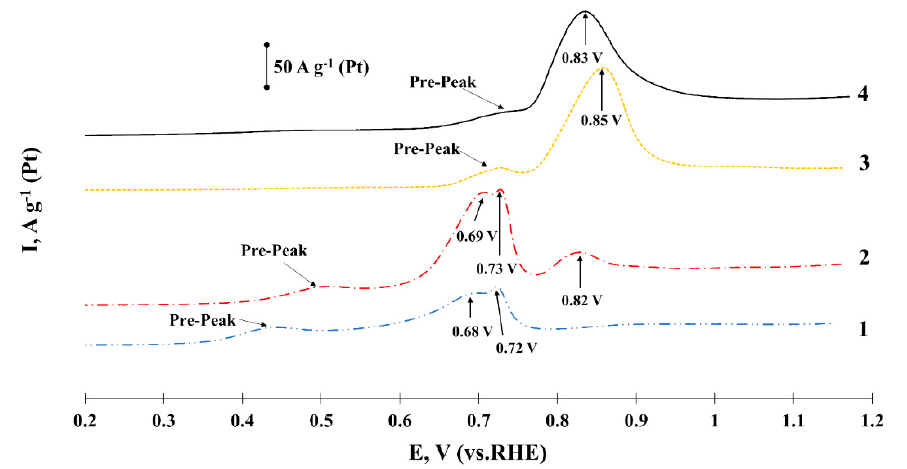
Figure 7. Cyclic voltammograms (2nd cycle). Electrolyte—1 M HClO 4 , Ar atmosphere. Potential sweep speed 40 mVs − 1 : 1—PCC1; 2—PC ‐ 2; 3—Pt/C (JM20); 4—Pt/C (JM40). Table 3. Parameters characterizing the electrochemical behavior of catalysts .